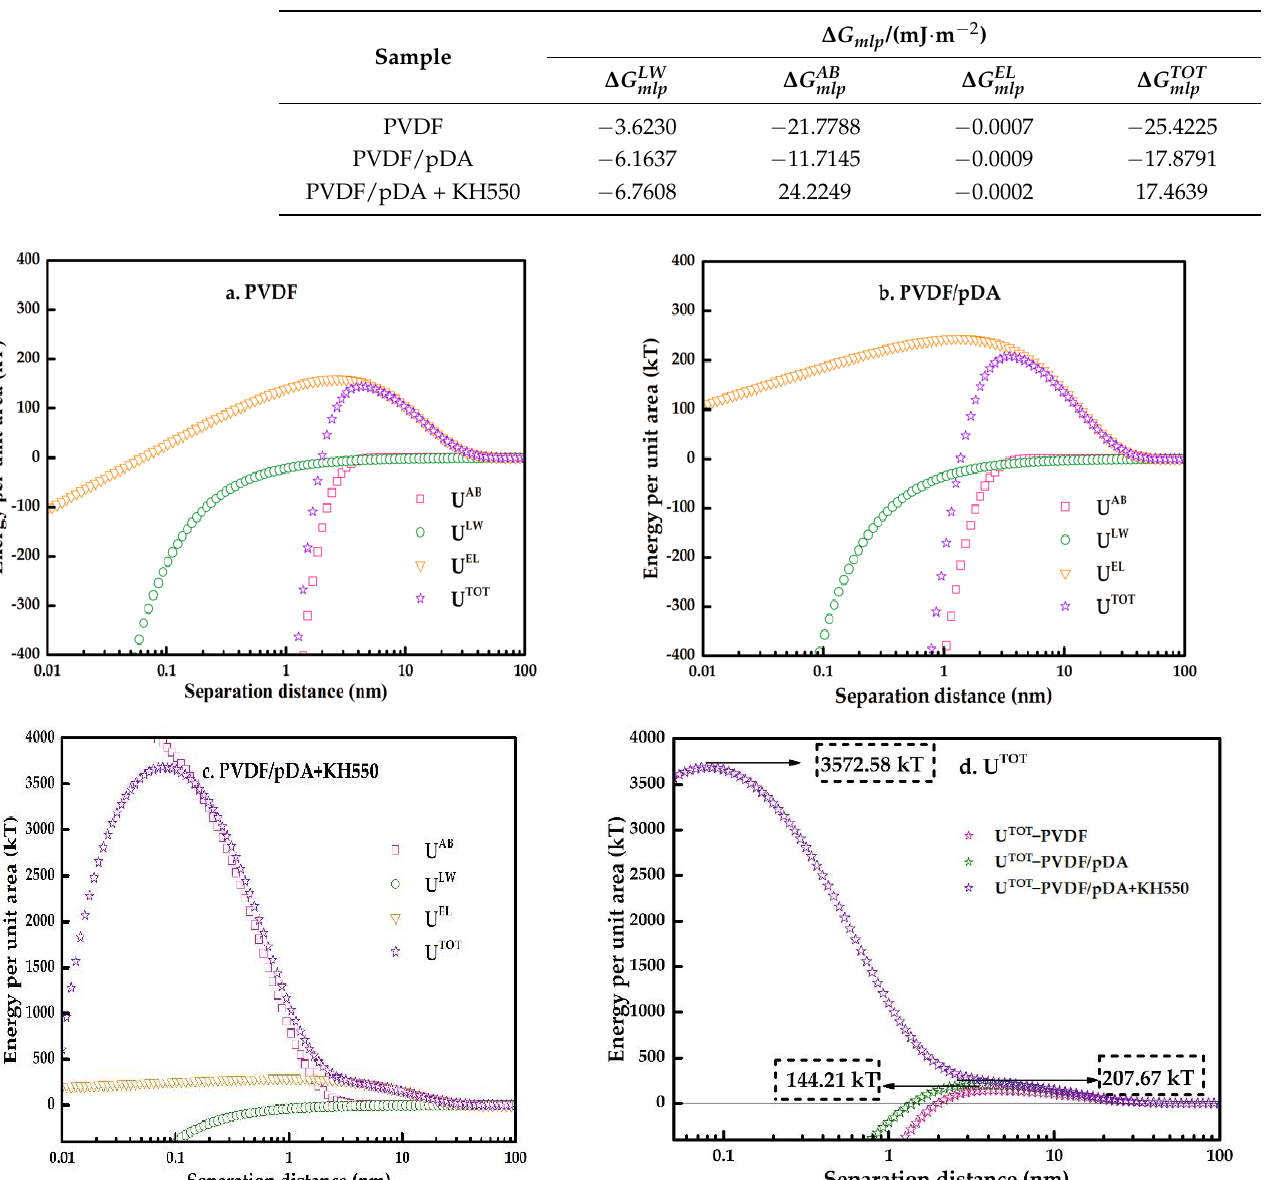
Table 6. Interfacial energy between pectin and membranes.